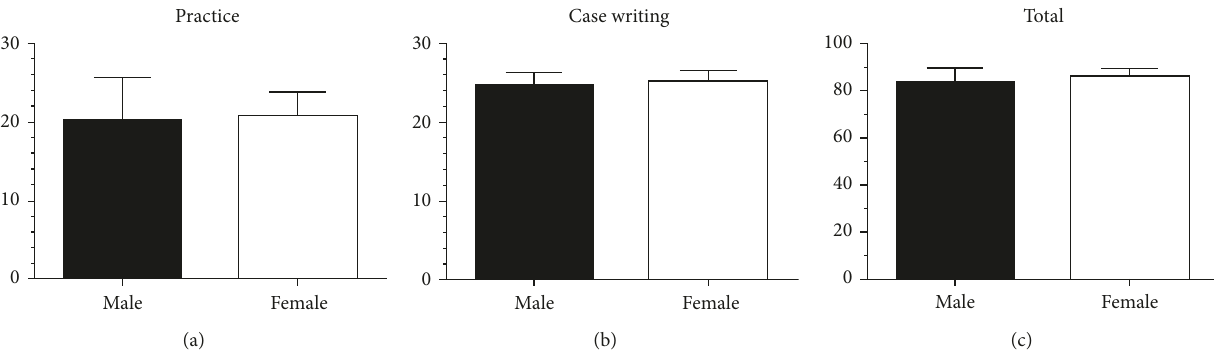
Figure 3: Comparison of scores in MTBL at the end of the clerkship. The test scores between genders are represented. (a) Practice scores. (b) Case-writing scores. (c) Total scores.